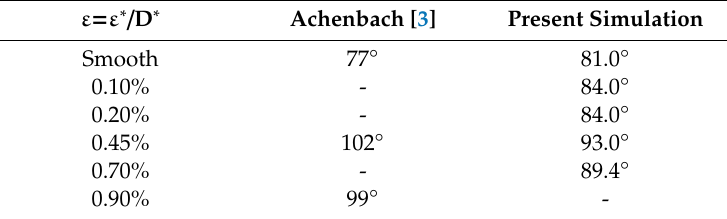
Table 2. Upper side angular position of boundary layer separation, θ sep (Re = 1.0 × 10 5